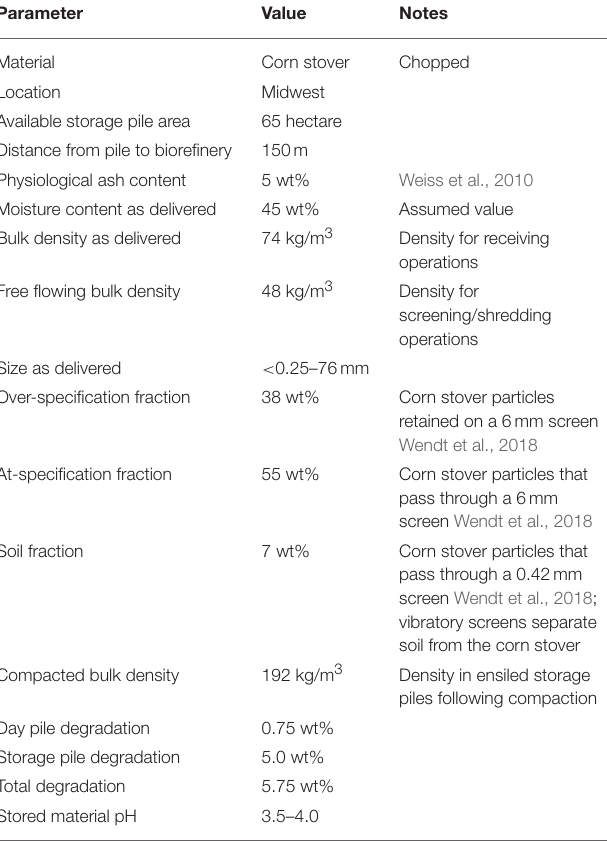
TABLE 4 | Truck receiving/day pile design parameters for preprocessing & storage operations of the chopped logistics system.